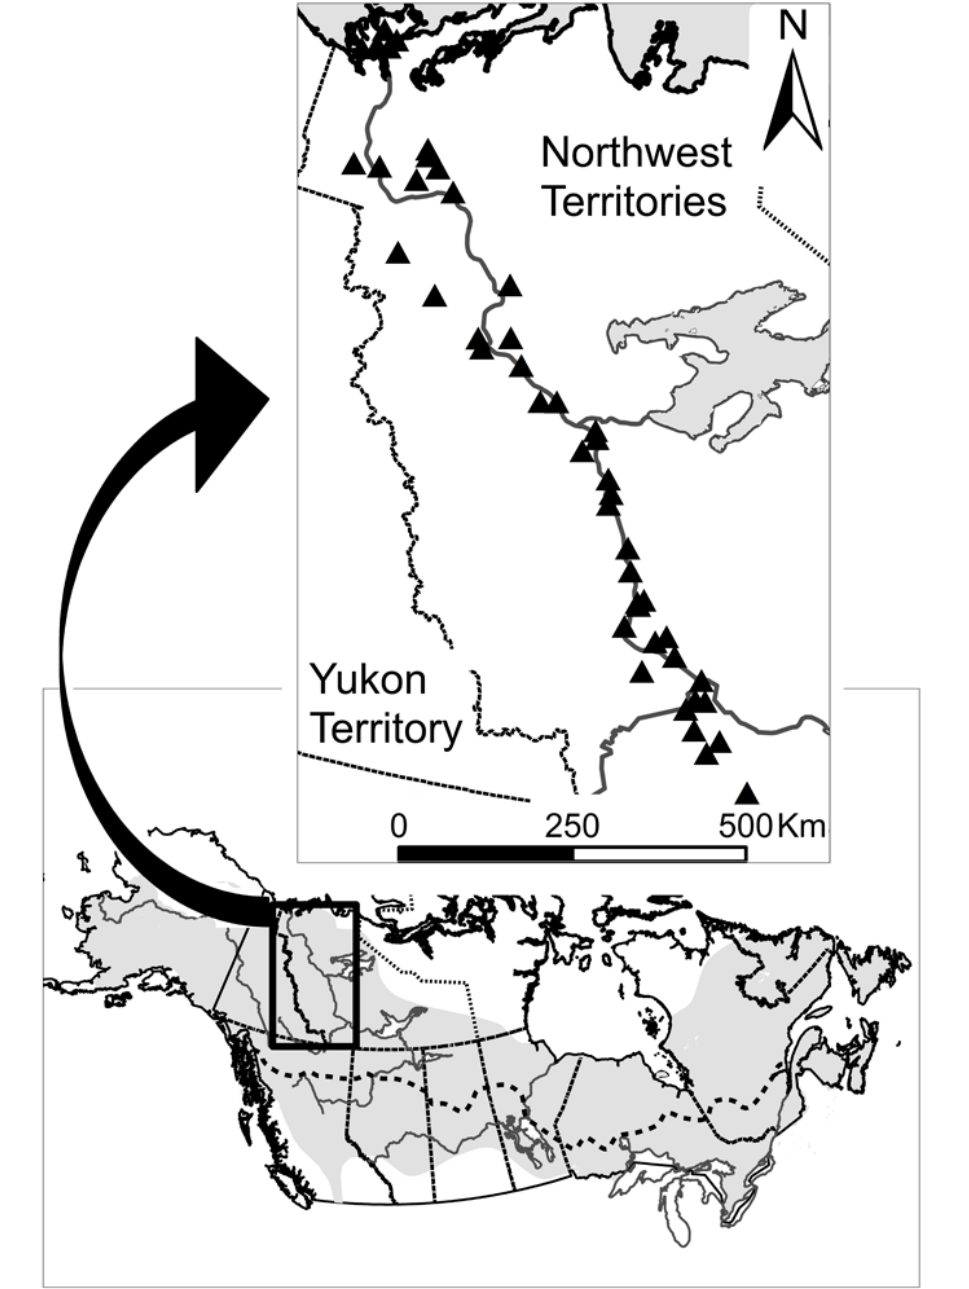
Fig. 1. Study area is shown in the black rectangle and inset, breeding range of the Rusty Blackbird in Canada is shown in gray shading after COSEWIC (2006), and location of 45 lakes visited within the Mackenzie Valley, NT are the black triangles for this study. The dashed line on the Canada-wide map represents the northern limit of valid analyses from the Breeding Bird Survey (from Sauer et al.